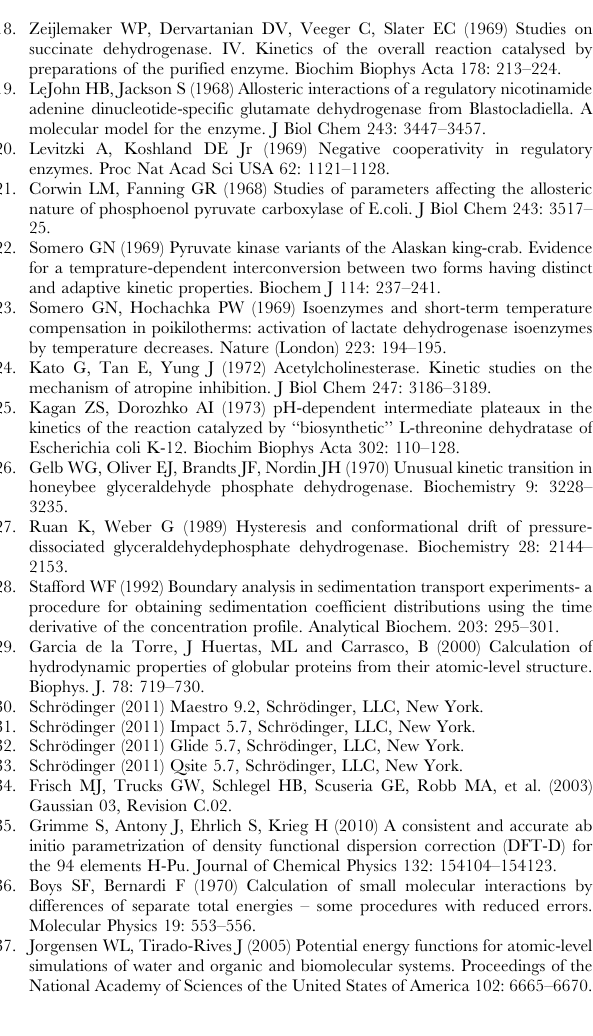
Figure S1 Kinetics of WrbA at high concentrations of NADH or BQ. Assays were carried out at 5 u C to reveal the two- plateau behavior.